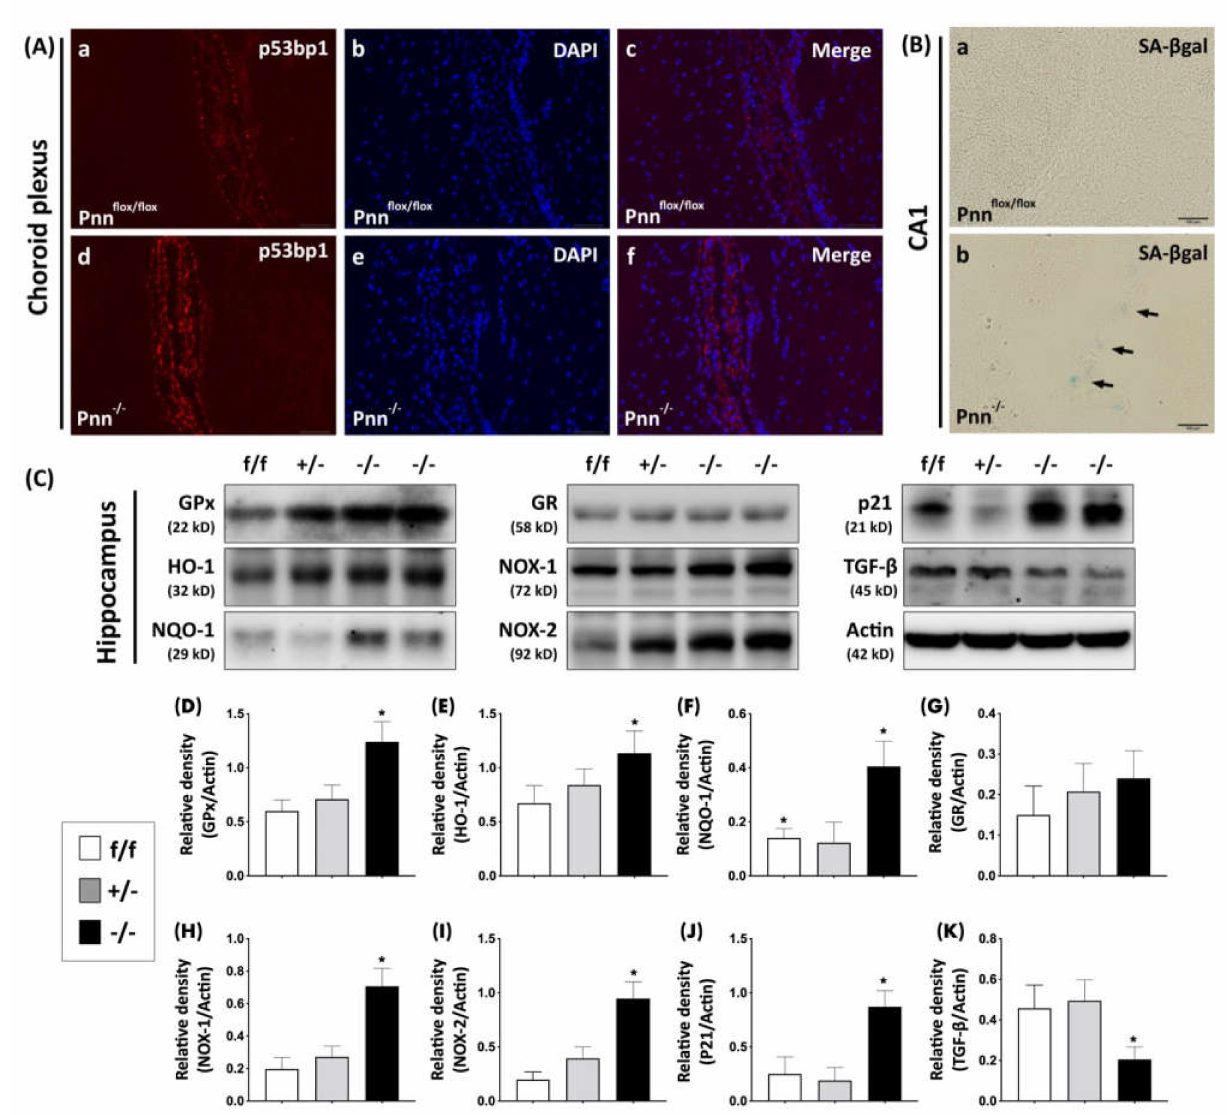
Figure 5. Examination of senescence phenotype in brains with neuronal Pnn depletion. ( A ) Im- munostaining to detect p53bp1, a DNA damage marker, in the choroid plexus. ( a – c ) Expression of p53bp1 in choroid plexus of Pnn flox/flox mice. ( d – f ) Expression of p53bp1 in choroid plexus of Pnn -/- mice. ( B ) Senescence-associated β -galactosidase activity measurement in hippocampus (black arrows) of Pnn flox/flox mice ( a ) and Pnn -/- mice ( b ). ( C ) Western blotting to examine the expression levels of antioxidative proteins (GPx, HO-1, NQO-1), ROS generators (NOX-1, NOX-2), senescence marker p21, and axon initiation protein TGF- β in hippocampus. ( D – K ) Quantitation and comparison of protein level of oxidative stress and senescence-associated proteins in hippocampus. Results showed that neuronal Pnn depletion increased DNA damage in choroid plexus, senescence- associated β -galactosidase activity in CA1 of hippocampus, hippocampal oxidative stress as well as p21 expression in hippocampus. p53bp, p53 binding protein 1. GPx, glutathione peroxidase. HO-1, heme oxygenase-1. NQO-1, NAD(P)H quinone oxidoreductase 1. GR, glutathione reductase. NOX-1, NADPH oxidase 1. NOX-2, NADPH oxidase 2. TGF- β , transforming growth factor- β . f/f, flox/flox mice. +/-, mice with heterozygous neuronal Pnn deficiency. -/-, mice with homozygous neuronal Pnn deficiency. n = 4 for each group. * indicates significance compared with f/f